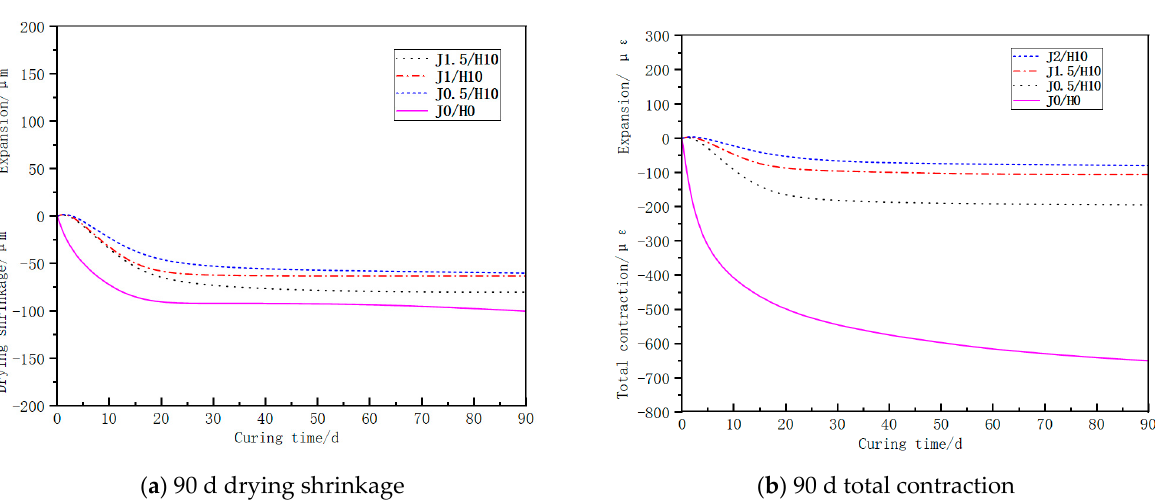
Figure 10. Combined effect of HPEA and shrinkage-reducing agent on concrete drying and total Figure 10. shrinkage.